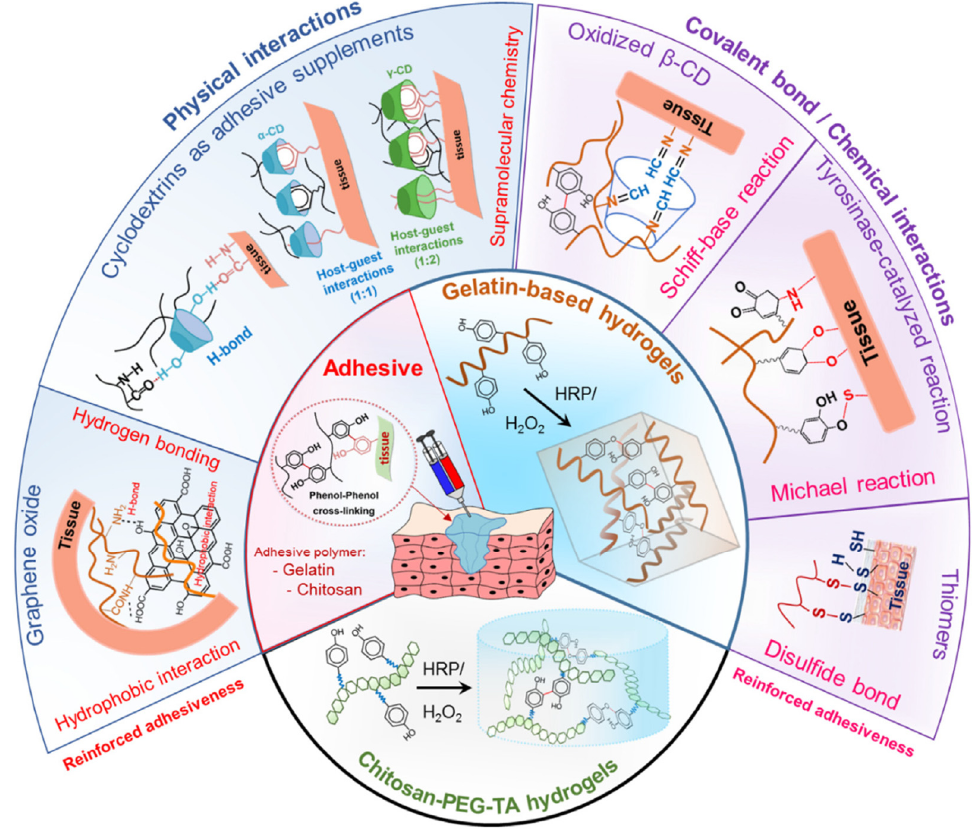
Figure 7. Development strategy of in situ forming horseradish peroxidase (HRP) catalyzed hydrogels with significantly enhanced adhesiveness through polymer choices and additional crosslinking. Reproduced from [48] with permission. Copyright 2019 The Korean Society of Industrial and Engineering Chemistry. Published by Elsevier B.V. All rights reserved.